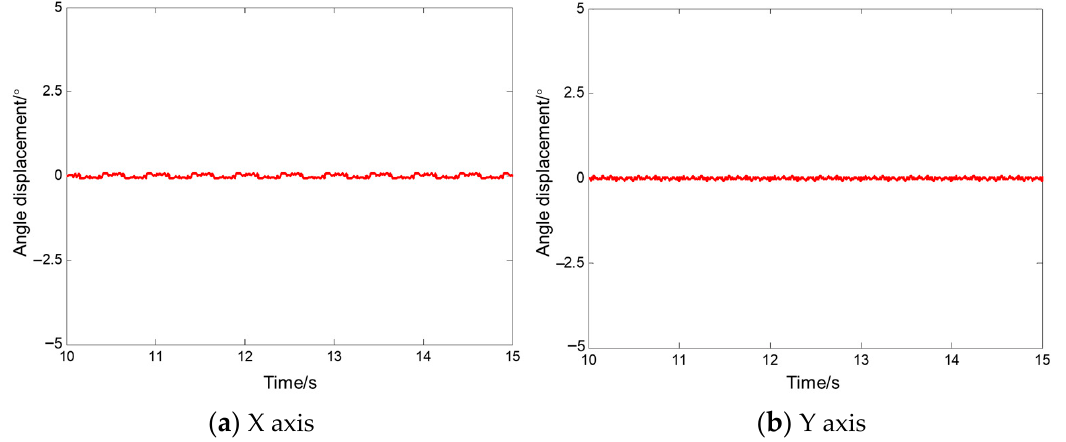
Figure 9. Holds test results at an equilibrium position.